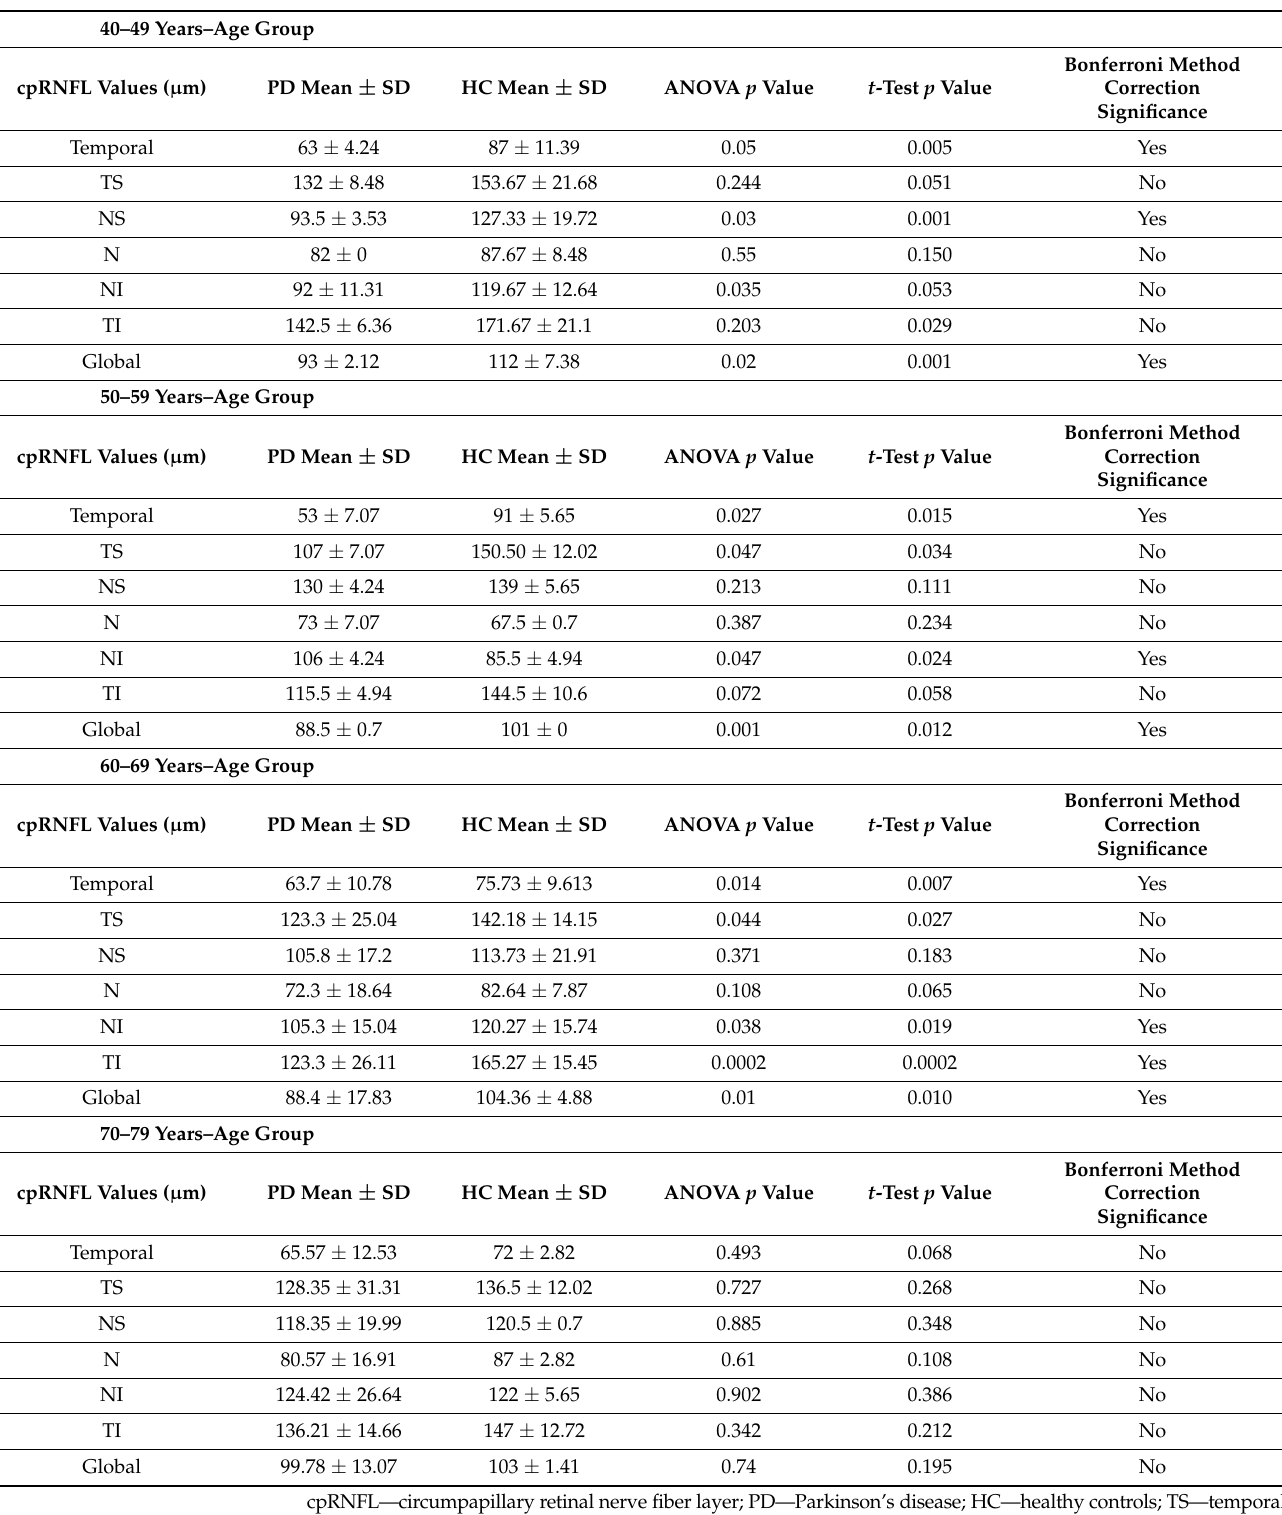
Table 3. Retinal layer thickness in PD patients and